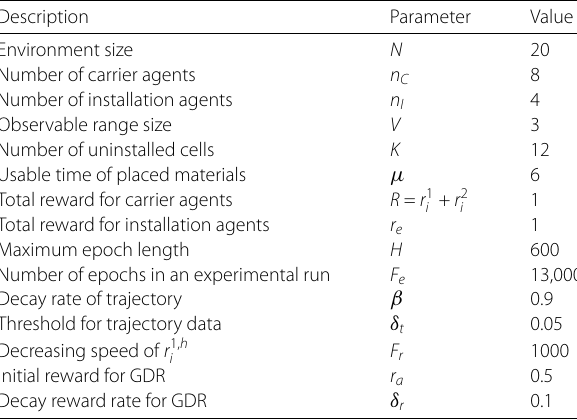
Table 3 Parameters and values in experiments